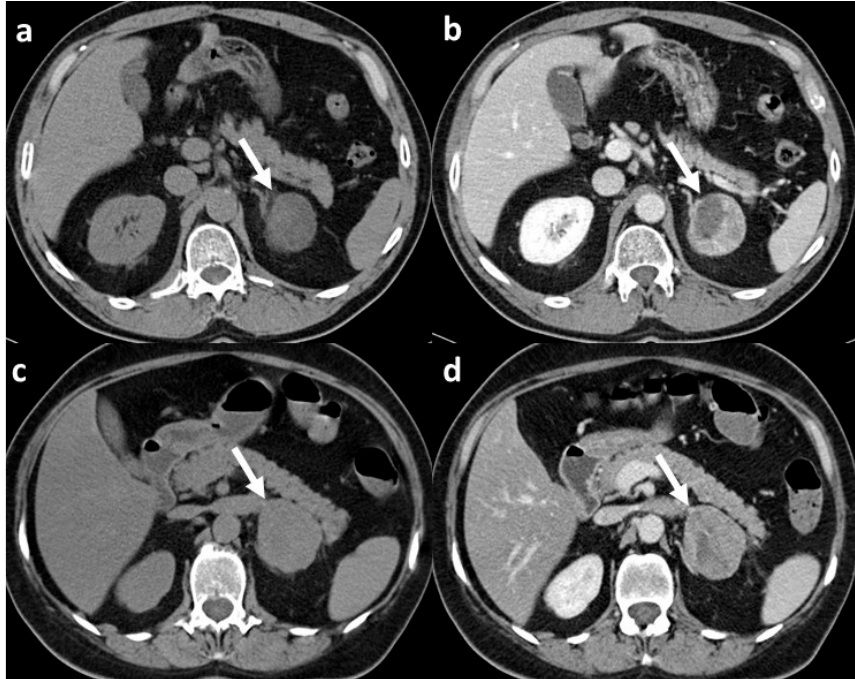
Figure 1. CT scans of adrenal adenoma and adrenocortical carcinoma both with CT features suspect for malignant lesion: ( a ) unenhanced scan of histopathologically confirmed adrenal adenoma (arrow) with mean densitometry of 22 HU; ( b ) venous phase scan of the same adrenal adenoma (arrow), at late scan (not shown) the relative washout of contrast medium was <40%; ( c ) unenhanced scan of histopathologically confirmed adrenocortical carcinoma (arrow) with mean densitometry of 28 HU; ( d ) venous phase scan of the same adrenocortical carcinoma (arrow), and also in this case, at late scan (not shown), the relative washout of contrast medium was <40%.